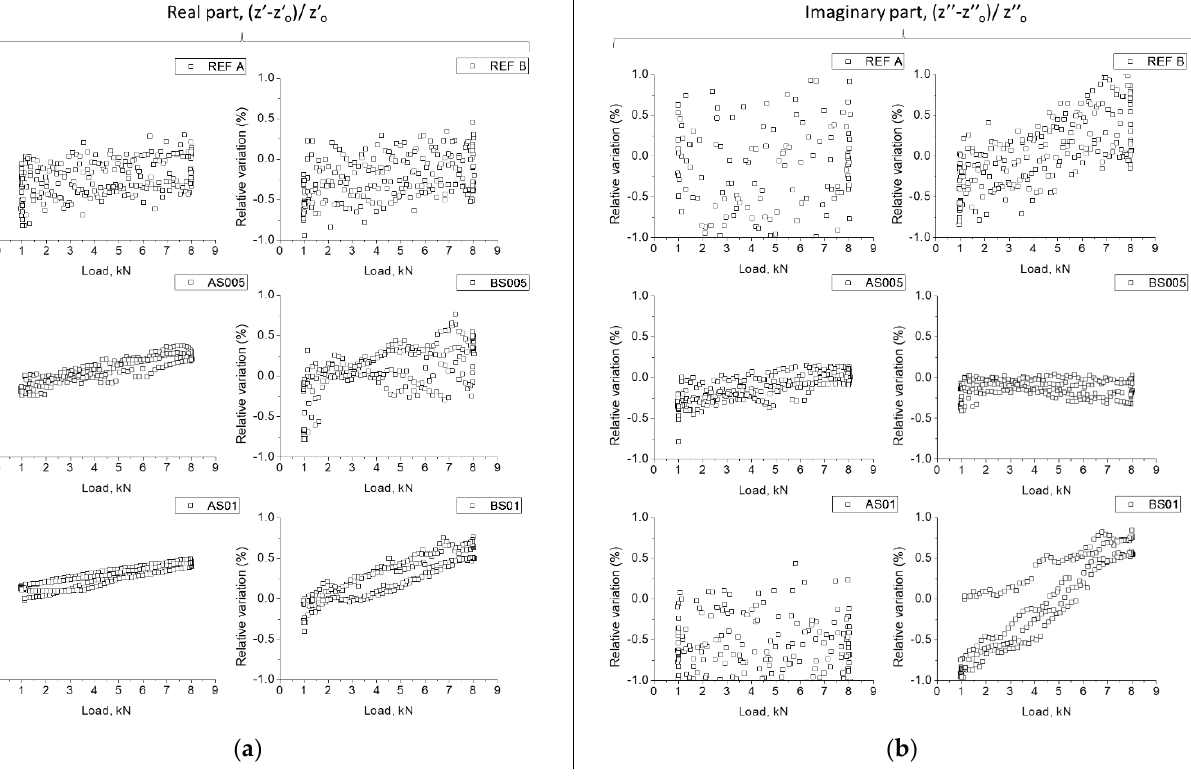
Figure 7. ( a ) Relative variation of the resistance (real part, Z ′ ) and ( b ) relative variation of the reactance (imaginary part, Z ″ ) with compressive loading for representative mortars at room temperature.